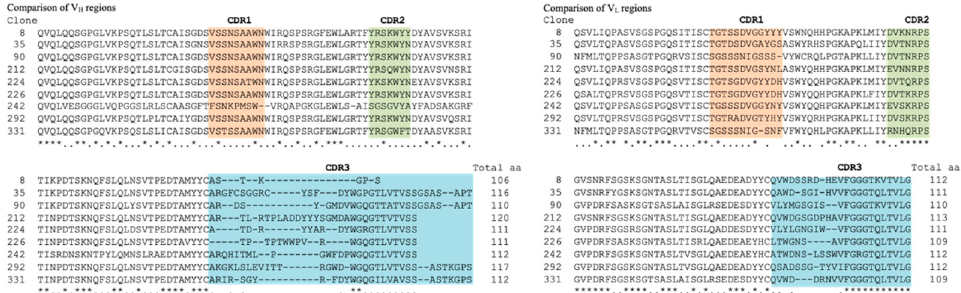
Figure 2. Comparison of the amino acid sequences of V H and V L regions in the nine clones isolated from the phage library by bio-panning. The domains corresponding to CDR1, CDR 2 and CDR 3 are highlighted with each colored background.